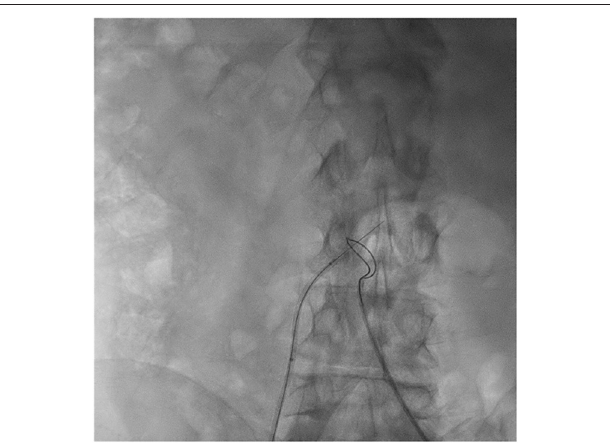
FIGURE 2 | Caval to abdominal aorta traversal. A 0.014 ′′ guidewire is positioned in the inferior vena cava pointing toward the abdominal aorta. A loop snare is positioned at the abdominal aorta at the level of the calcium-free window identified in preprocedural computed tomography. Using a catheter electrosurgery technique, the guidewire is electrified and advanced into the abdominal aorta to the center of the snare.